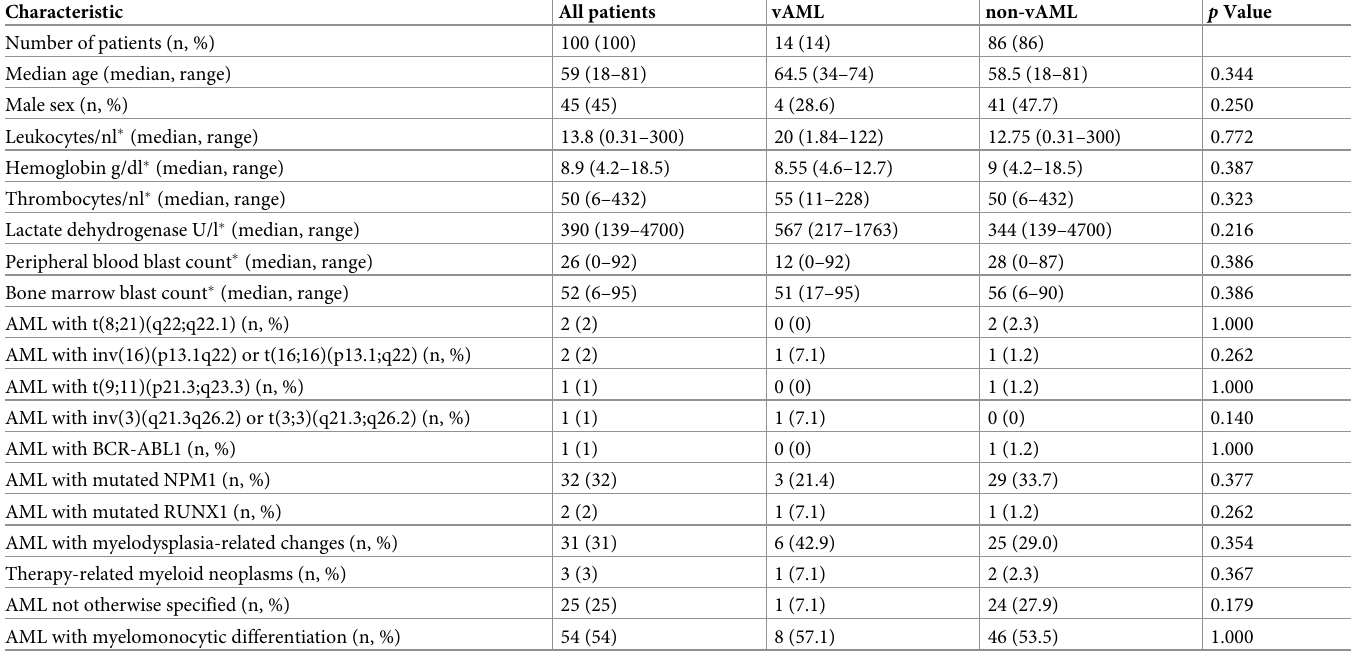
Table 1. Baseline